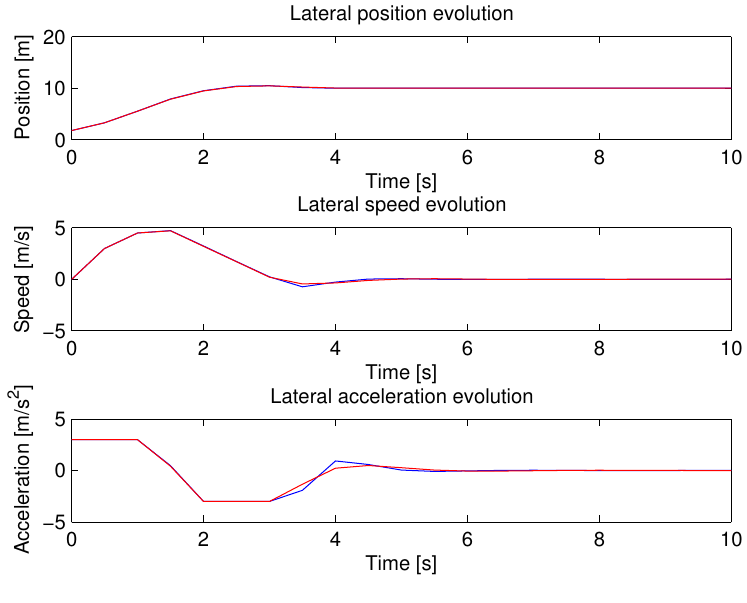
= 10 s). (red) ( t D 4 f